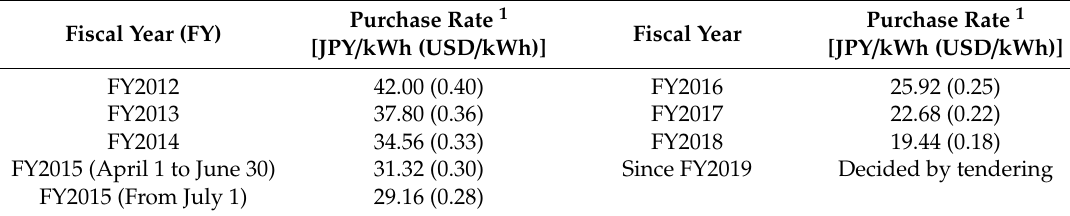
Table 1. Power purchase rates for mega PV solar plants [30].